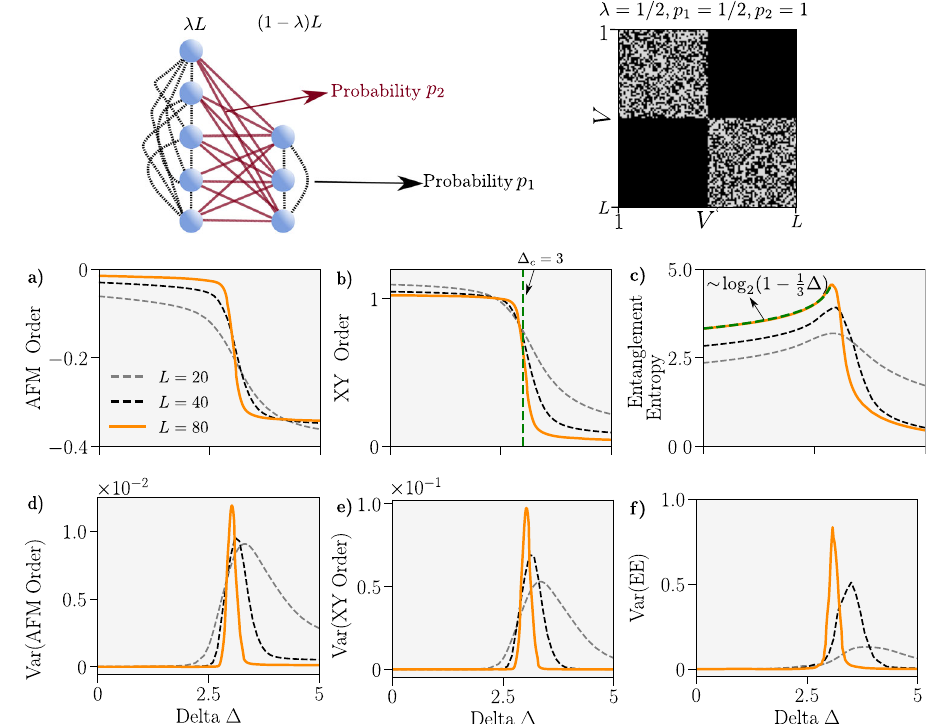
Fig. 3 | Properties of the ground-state of the spin 1/2 XXZ Hamiltonian on a random graph with a non-trivial cut, G ð λ , p 1 , p 2 Þ . A graph schematic is provided top left. Weset λ =1/2, p 2 =1and p 2 =1/2here and anexample adjacencymatrixfor L =100 and these parameters is shown top right. a – c Average anti-ferromagnetic order C AFM , XY order C XY and Von-Neumann entanglement entropy (EE) between